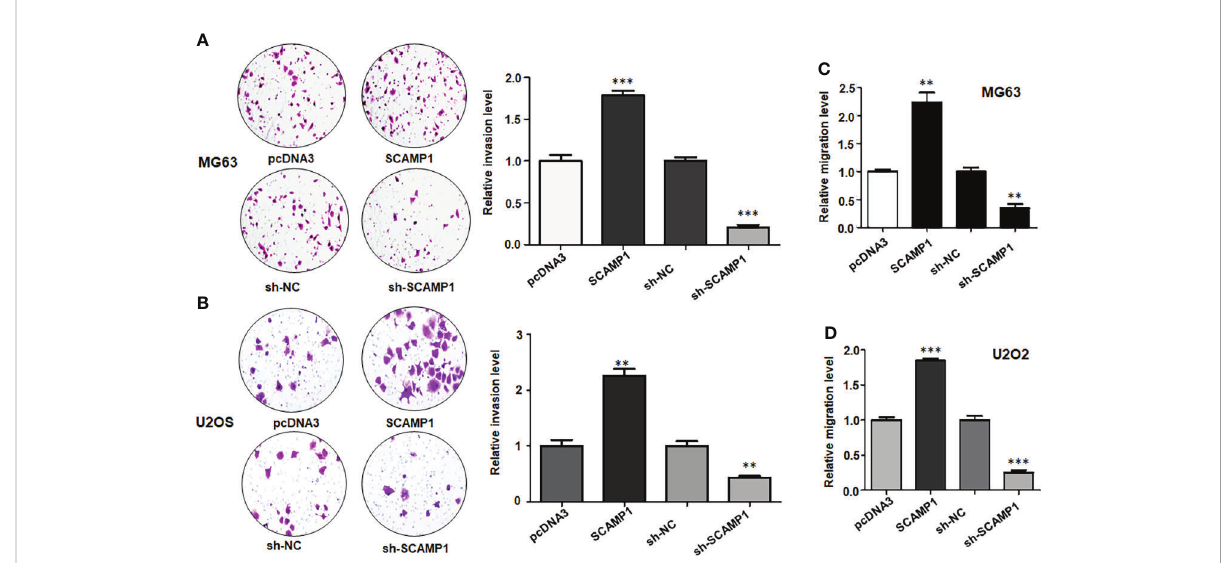
FIGURE 3 LncRNA SCAMP1 overexpression increases invasive and migratory abilities of osteosarcoma cells. (A) : Left panel: Transwell invasion assays showed that sh-SCAMP1 transfection reduced invasion of MG63 cells, while SCAMP1 cDNA transfection increased invasion of MG63 cells. Right panel: quantitative data is shown for invasive ability of MG63 cells. (B) : Left panel: Transwell invasion assays showed that sh-SCAMP1 transfection and SCAMP1 cDNA transfection modulated invasion of U2OS cells. Right panel: quantitative data is shown for invasion ability of U2OS cells. (C) : Wound healing assays showed that sh-SCAMP1 transfection reduced migration of MG63 cells, while SCAMP1 cDNA transfection increased migration of MG63 cells. (D) : Wound healing assays showed that sh-SCAMP1 transfection and SCAMP1 cDNA transfection modulated migratory ability of U2OS cells. **p<0.01; ***p<0.001 vs. control